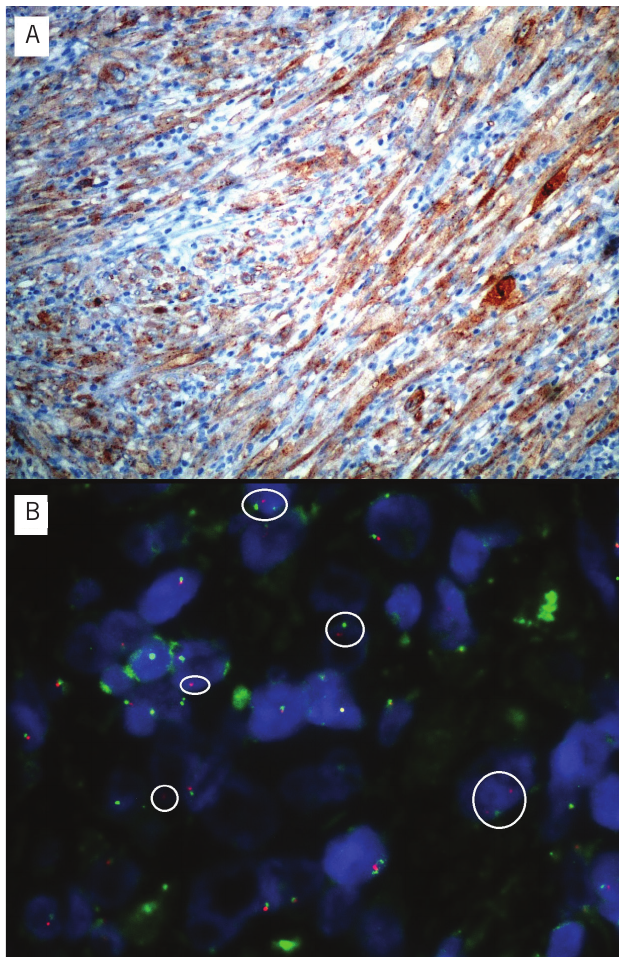
figuRE 3 − Immunohistochemistry and FISH for ALK A) the neoplastic cells showed a cytoplasmic granular staining for ALK, 200×; B) FISH revealed rearrangement of ALK gene in 52% of the neoplastic cells studied, characterized by separation of the telomeric (red) and centromeric (green) signals of the ALK break-apart probe used. FISH: fluorescent in situ hybridization; ALK: anaplastic lymphoma kinase.